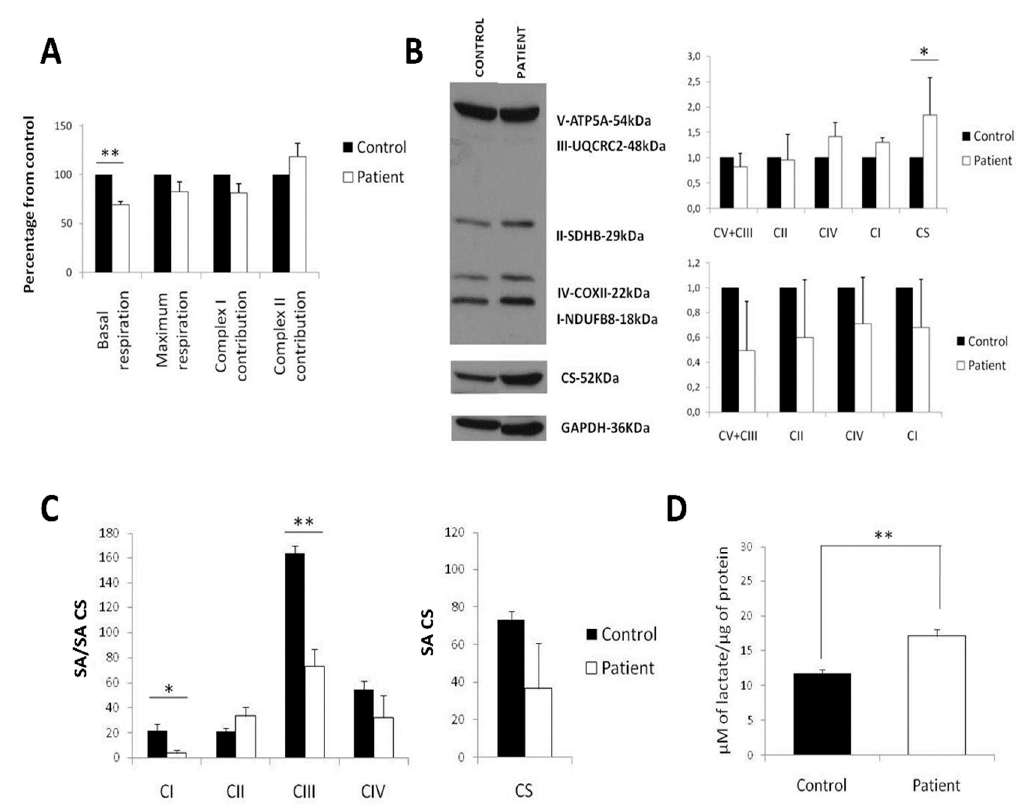
Figure 2. LS induced pluripotent stem cells (iPSCs) manifest a decreased basal respiration and a combined respiratory chain (RC) deficiency. ( A ) Oxygen consumption measured in Oroboros Oxygraph-2k. All data are displayed as a percentage of control. ( B ) Western blot assay against mitoprofile, citrate synthase (CS) and GAPDH (left). Quantification of the Western blot, normalized with GAPDH as a marker of the total protein (right, top panel) or GAPDH and citrate synthase (CS) as a marker of mitochondrial mass (right, bottom panel). All data are displayed as a percentage of control. ( C ) Spectrophotometric measurements of the activity of ETC complexes (left) and citrate synthase (CS) (right); SA: specific activity. ( D ) Extracellular lactate production normalized by total protein. (* p -value < 0.05; ** p -value < 0.01; *** p -value < 0.001)